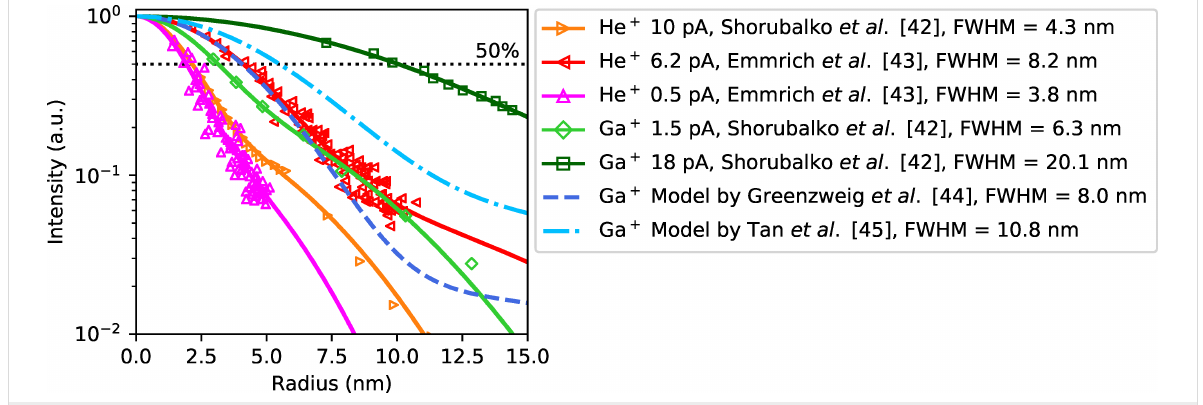
Figure 6: Comparison of the normalized ion beam profiles (normalized half profiles = beam radius) obtained from 1/fluence-dependent milled struc- tures of a helium beam (HIM) on different targets [42,43] and a Ga-LMIS driven FIB [44,45].